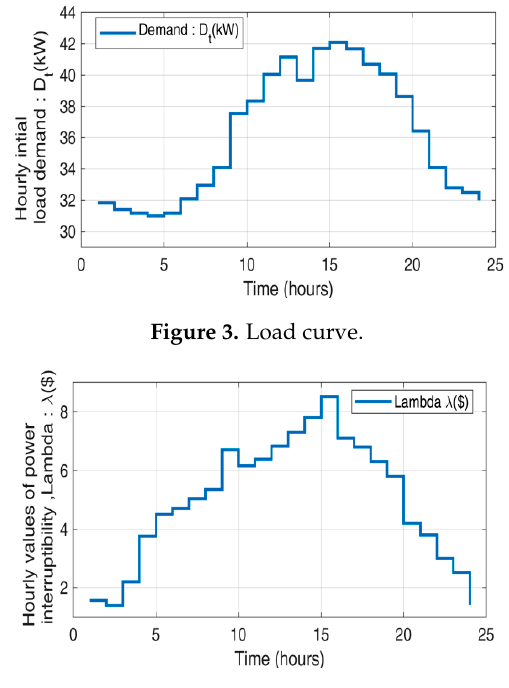
Figure 4. Power interruptibility curve.